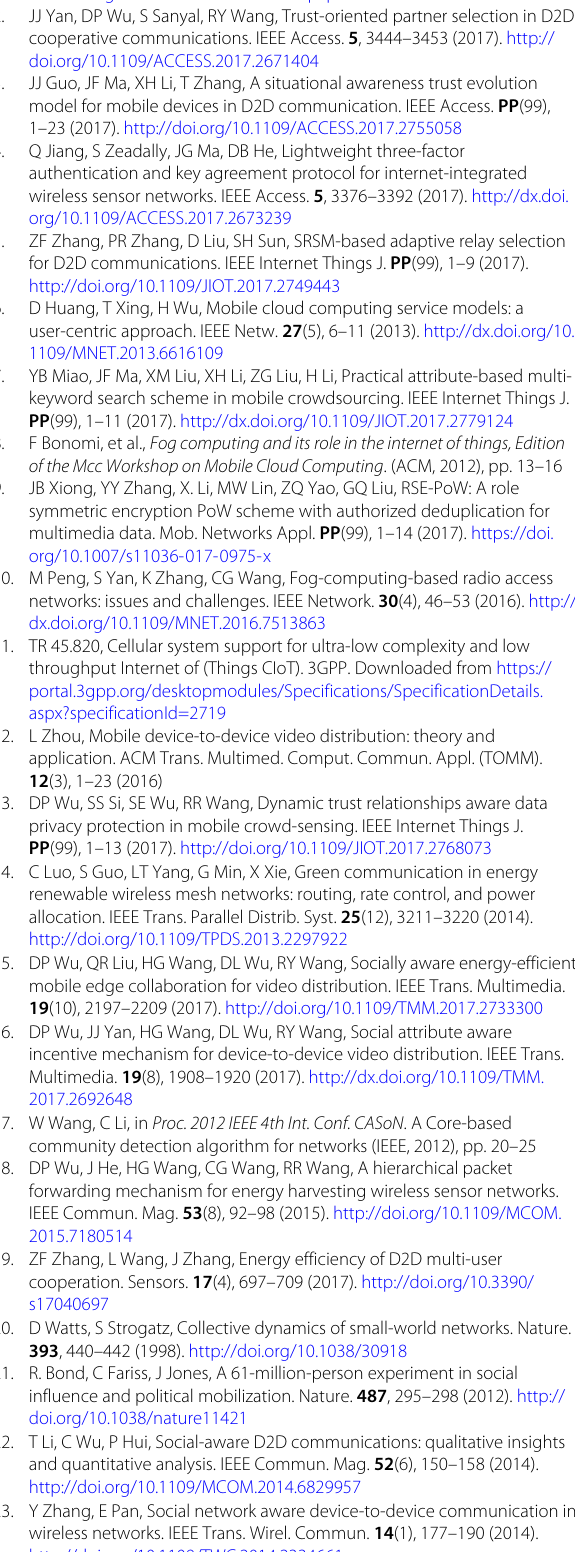
Fig. 7 The average delivery delay under various TTL of data